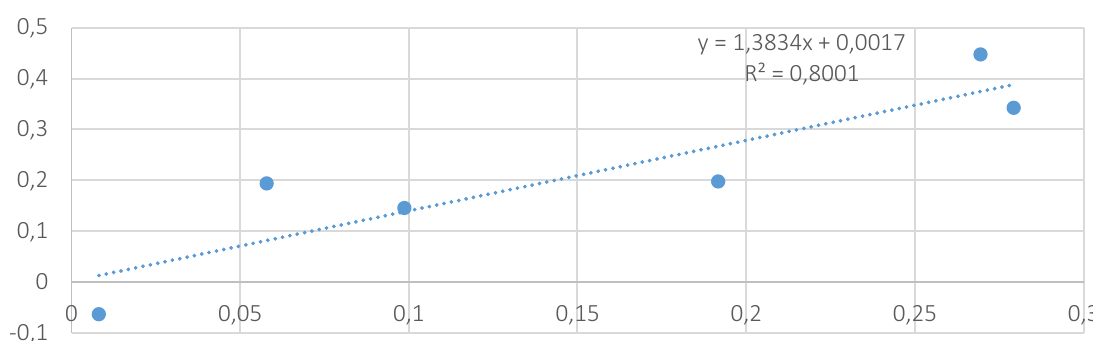
Figure 8. Regression line of NDX and ETF